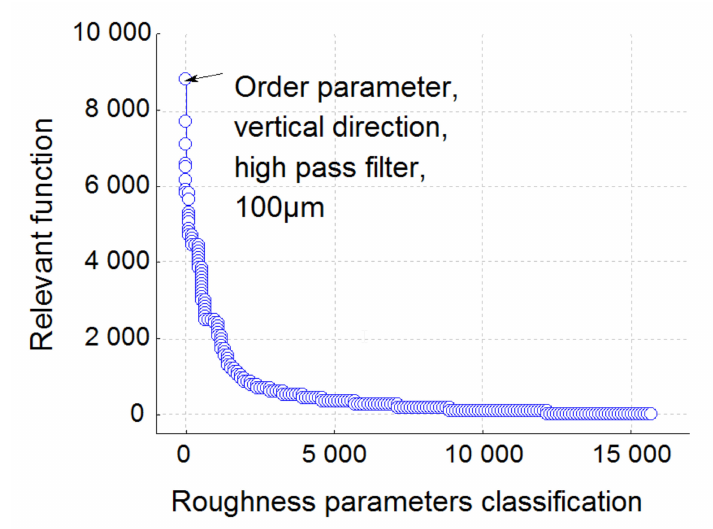
Figure 14. Relevance function for the Global model obtained from the 2D roughness parameters.